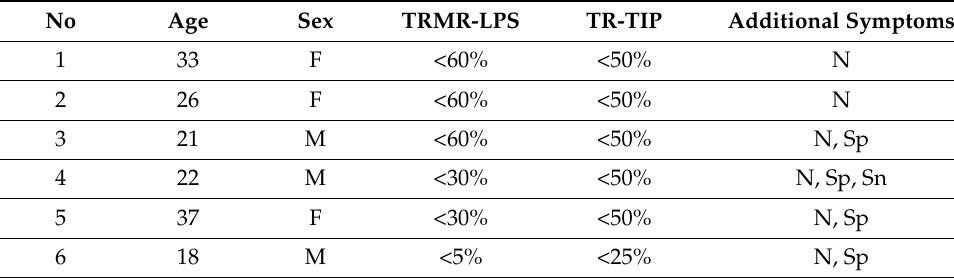
Table 1. Characteristics of patients before the surgery, M—male; F—female. No